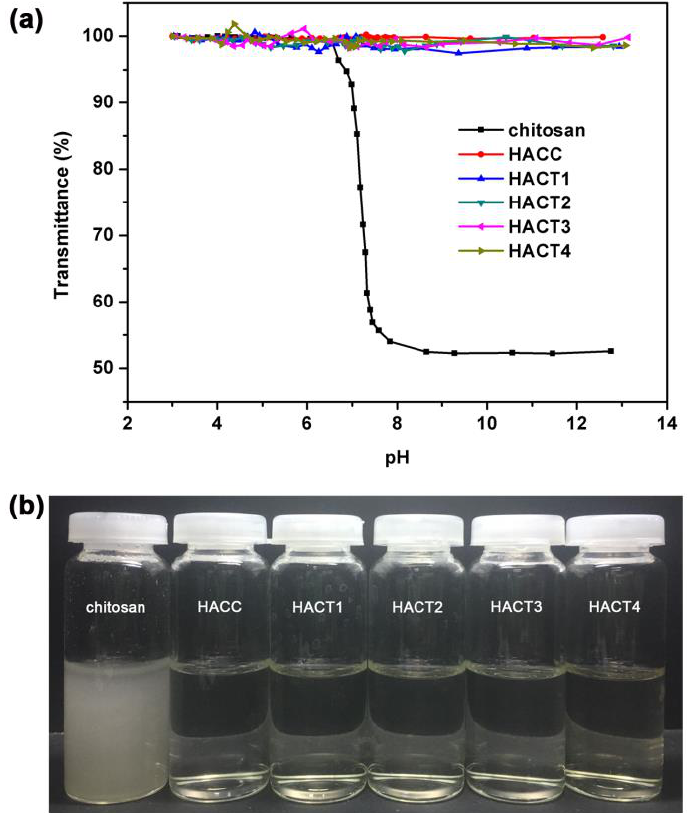
Figure 4. ( a ) pH dependence of water solubility and ( b ) optical photograph of chitosan and chi- tosan derivatives.